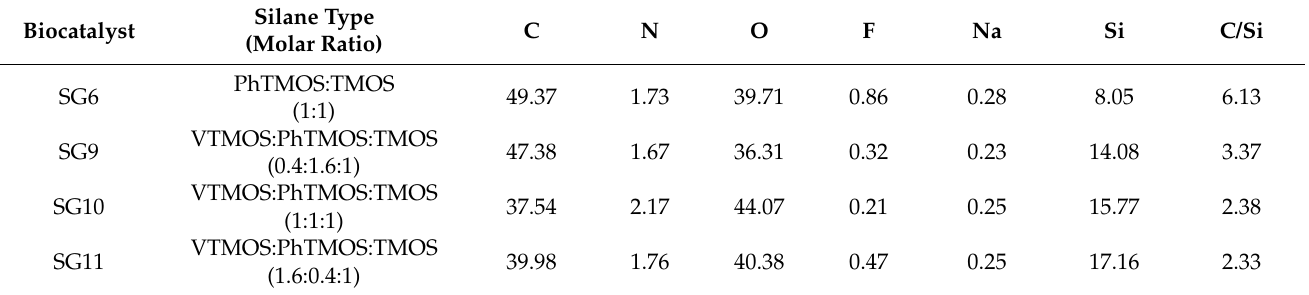
Table 3. EDS quantification of the immobilized biocatalysts in weight percentages (wt. %).